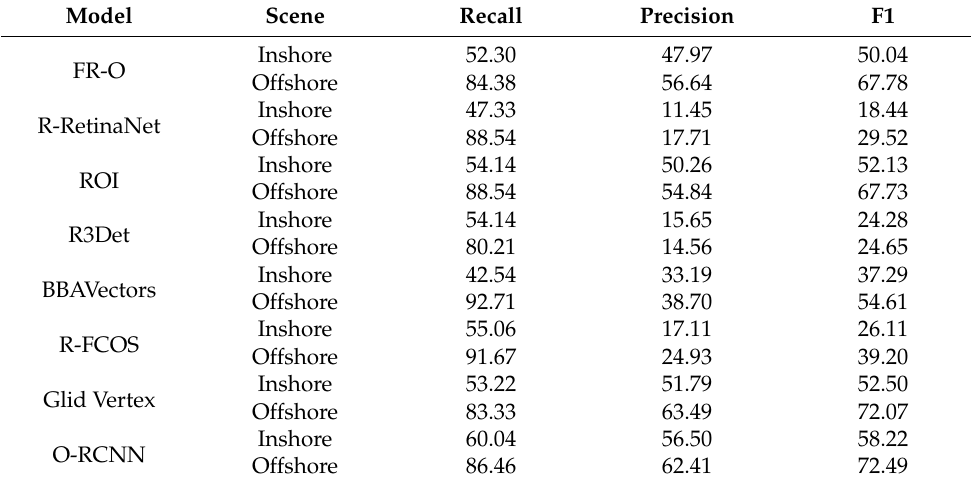
Table 7. The performance for inshore and offshore